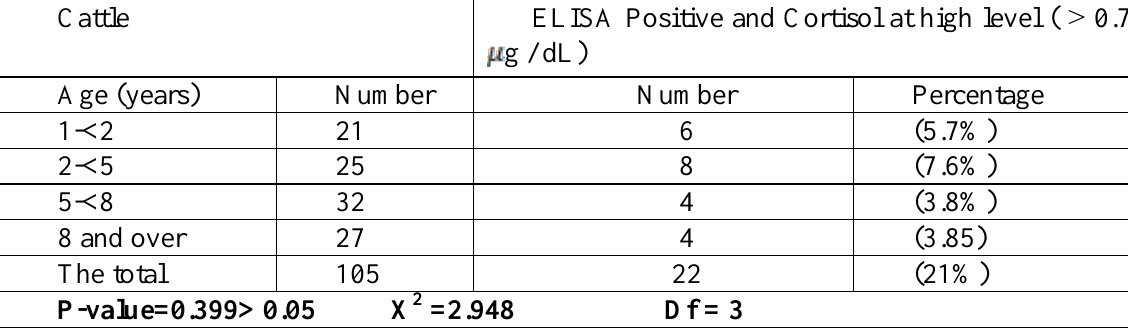
Table (4): The second group with ELISA posetive and cortisol at high level Cattle ELISA Positive and Cortisol at high level ( < 0.75 Age (years)